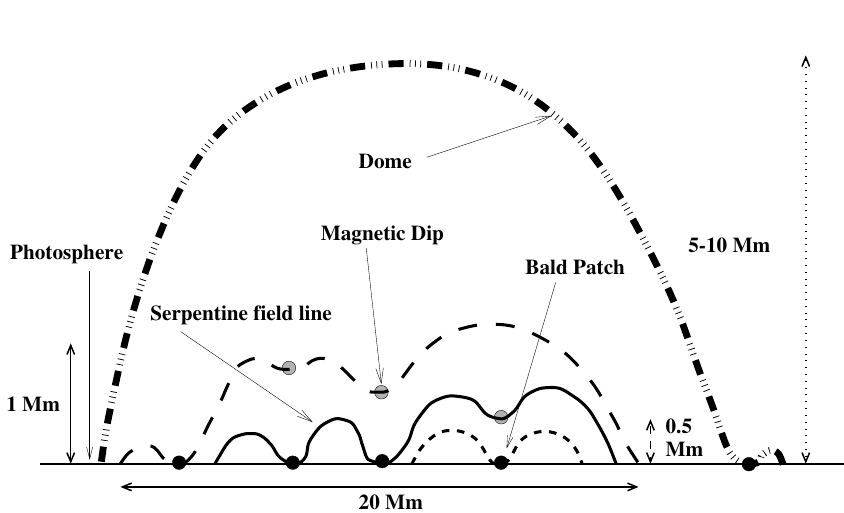
Figure 30: Schematic illustration of serpentine field lines in an emerging flux region. In this picture, development of the undular (Parker) magnetic buoyancy instability leads to loops with a characteristic separation of a few Mm. Magnetic dips occur between adjacent opposite polarities and reconnection between field lines from the polarities lead to plasma heating, which show up as Ellerman bombs in H 𝛼 observations. Image reproduced with permission from Pariat et al. (2004), copyright by